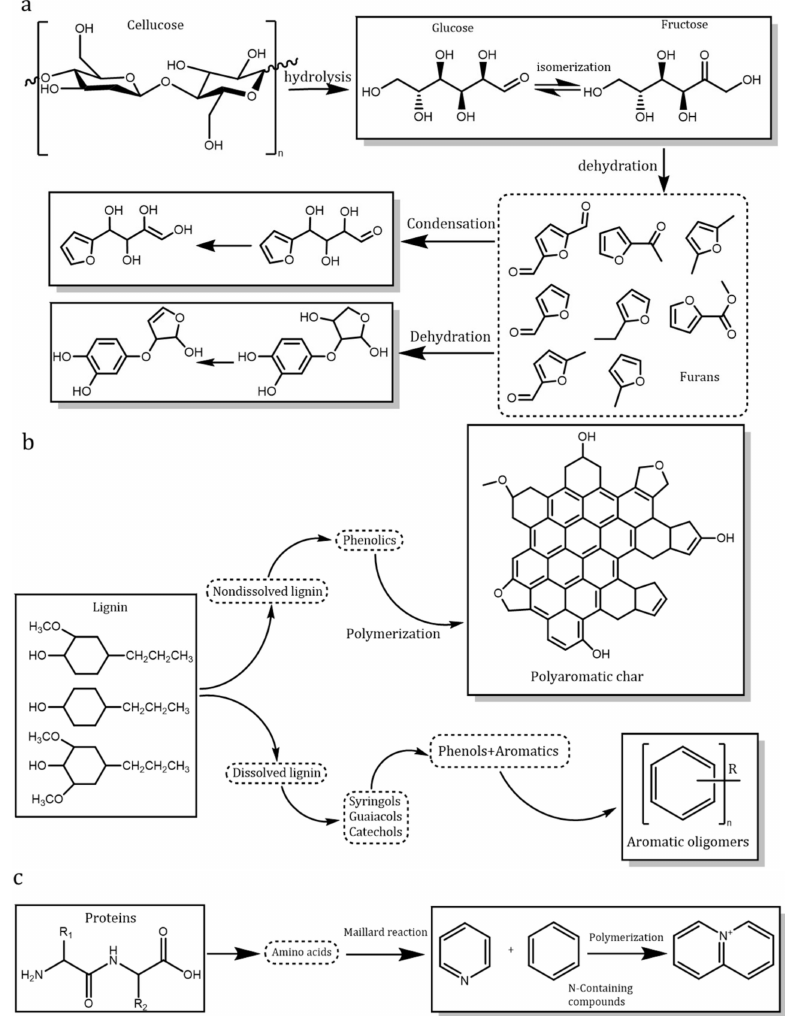
Figure 1. ( a ) Reaction pathways of cellulose and glucose decomposition during the HTC process; ( b ) Reaction pathways of lignin during the HTC process; ( c ) Reaction pathways of proteins during the HTC process